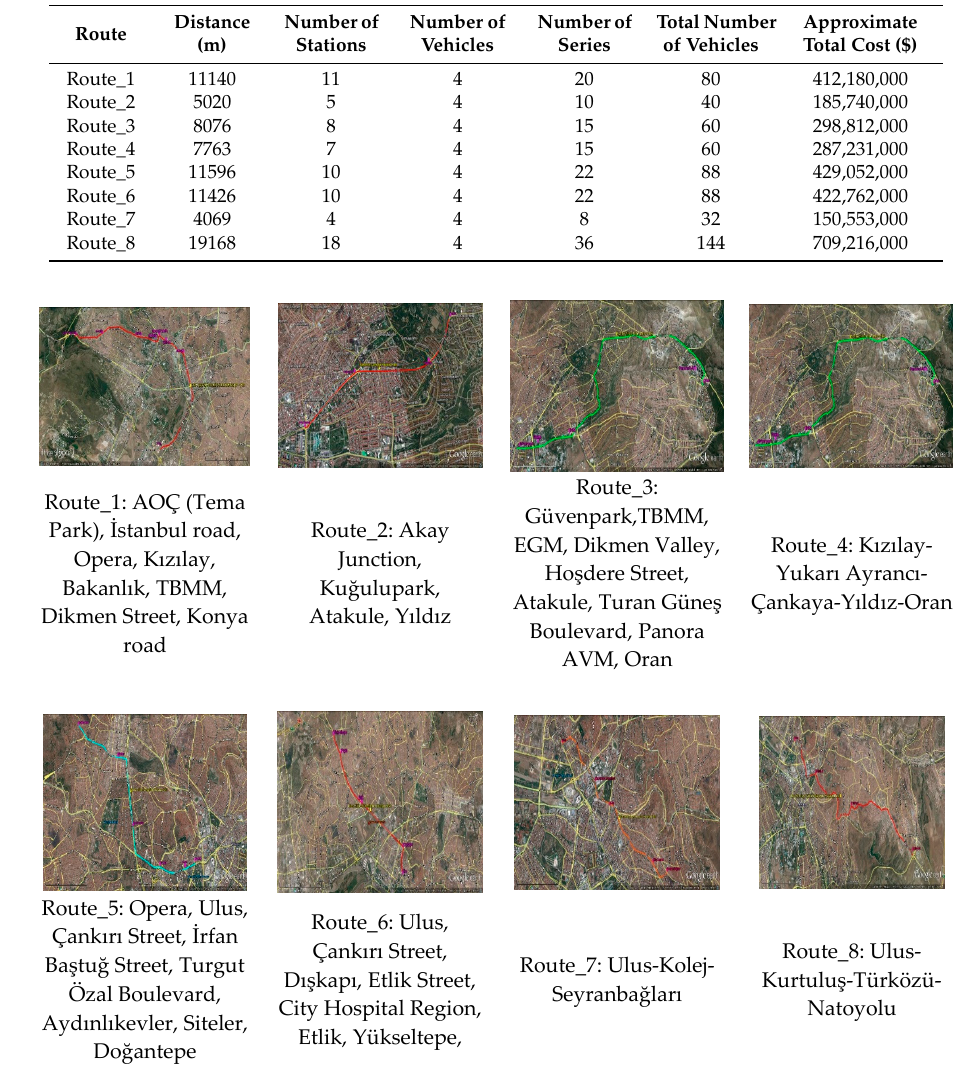
Figure 2. Alternative routes and their pictures in the map.